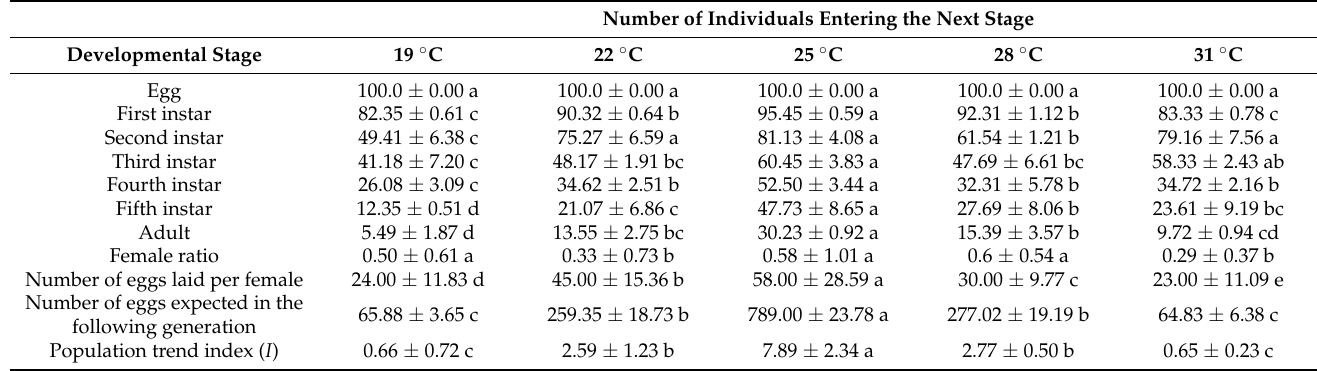
Table 4. Effects of temperature on the life table parameters of Riptortus pedestris